Question: What style of plot is this figure drawn as?
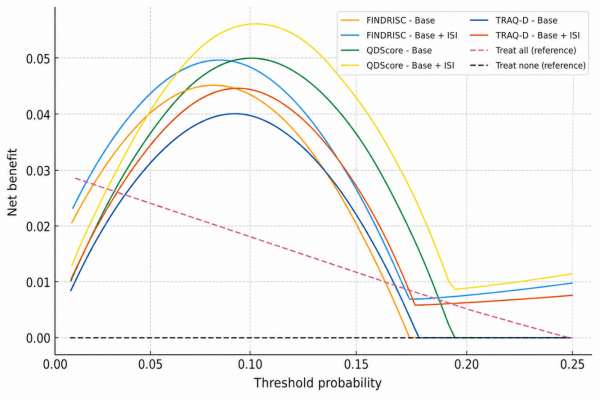
Answer: line